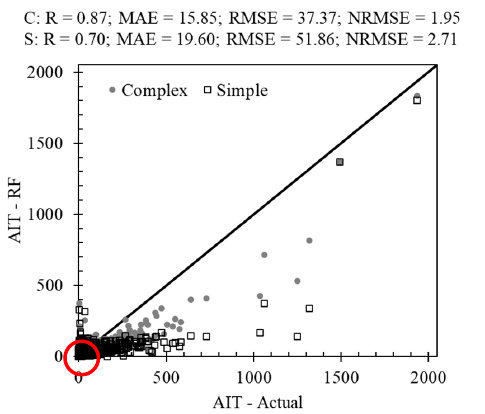
Figure 5. Scatter plot of the tree-based techniques in AIT forecasting. Plots on the right are a scaled- up view of the region circled in red in the left plot.